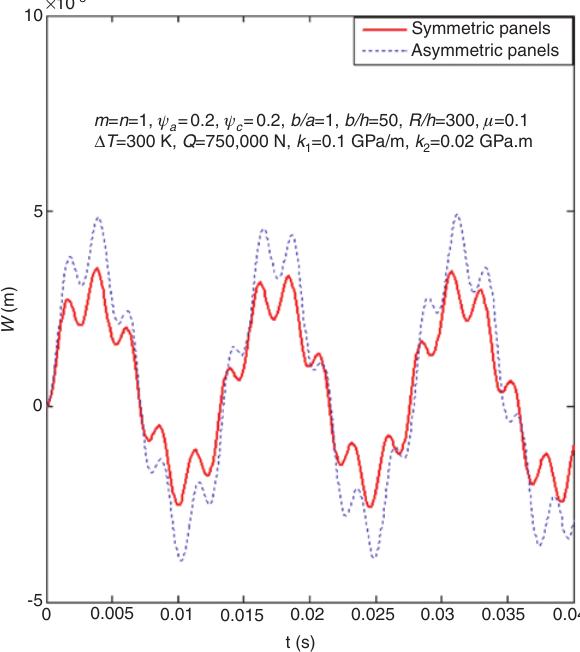
Figure 11: Non-linear dynamic response of the polymer composite cylindrical panel with different fibre